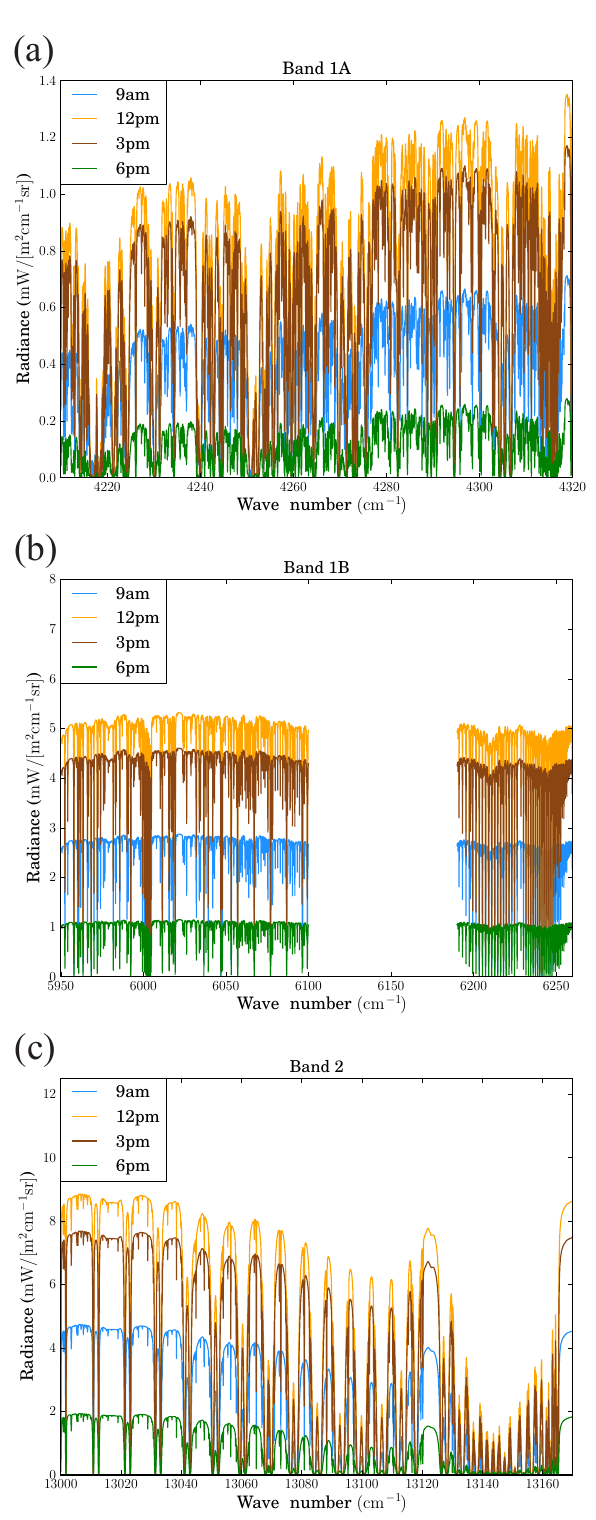
Figure 4. Modeled radiances in three spectral bands at four times of day at Location 1 on 26 July 2006.